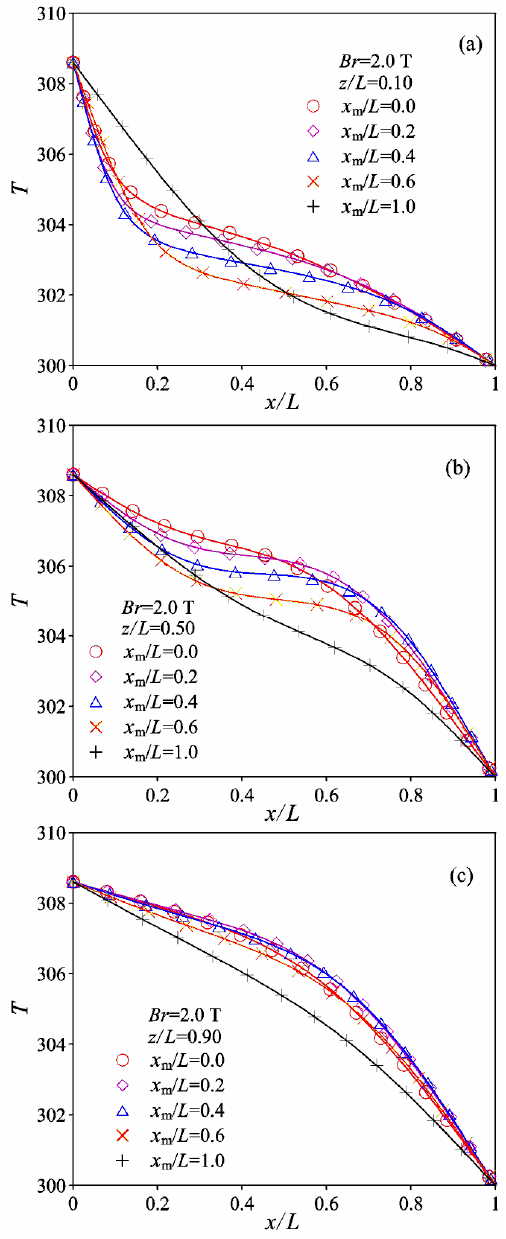
Figure 5. Distribution of T on the selected lines; ( a ) z / L = 0.1, ( b ) z / L = 0.5, and ( c ) z / L = 0.9.